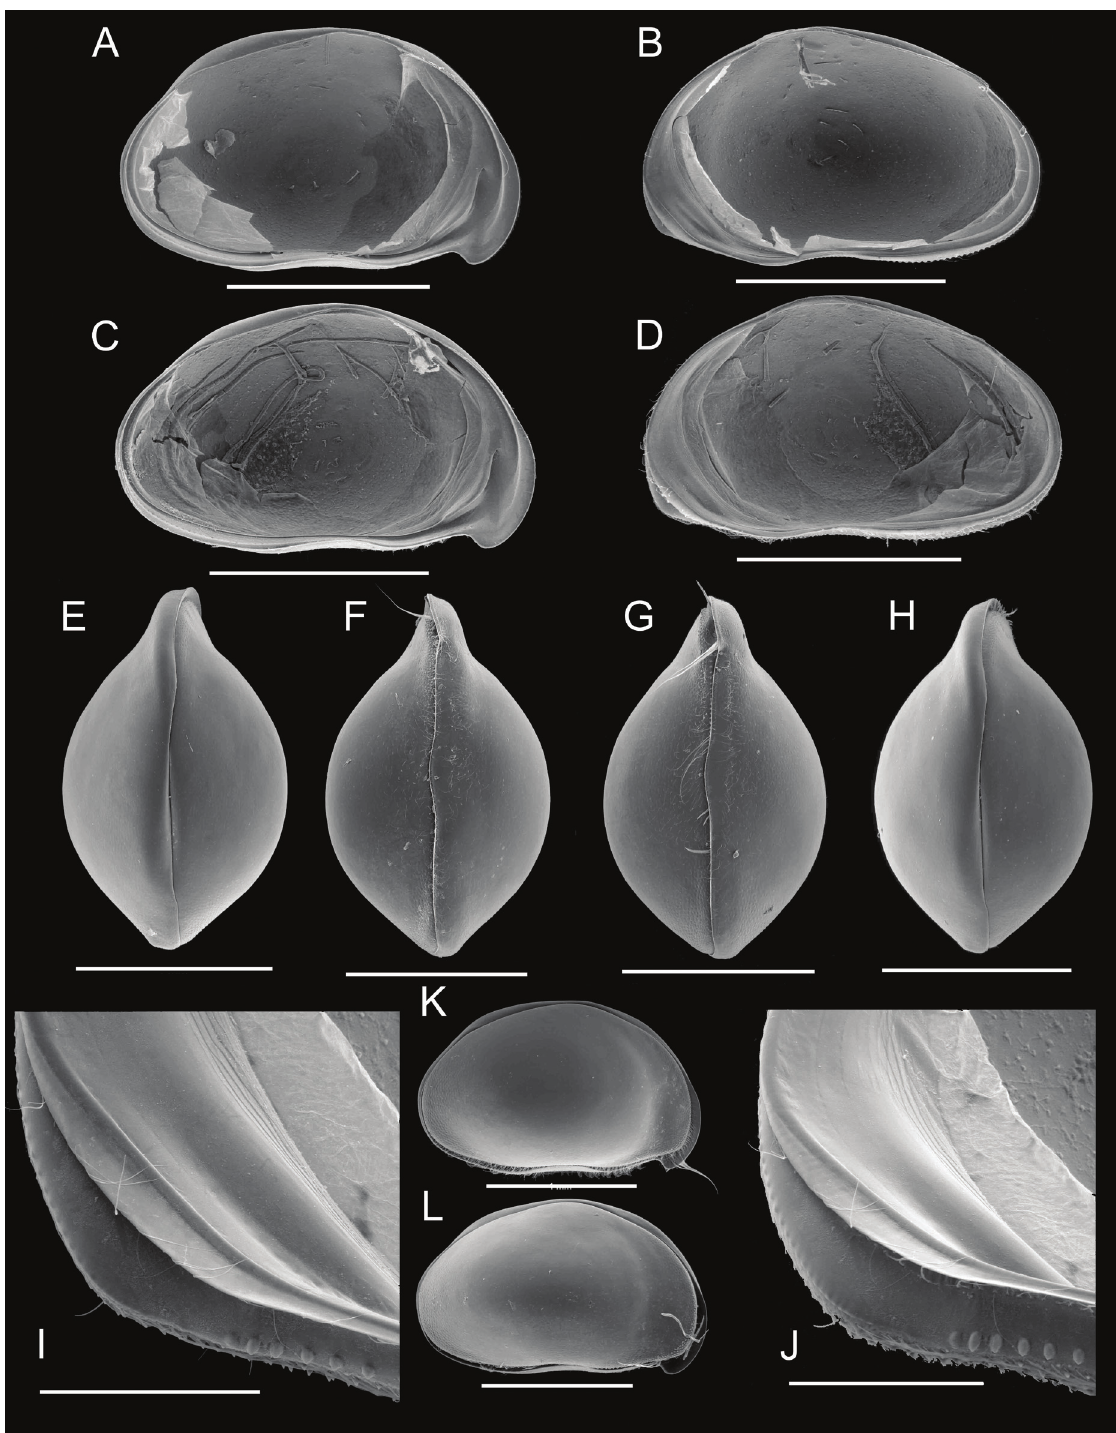
Fig. 21. Bennelongia strelleyensis sp. nov. (all from Strelley station, Pilbara, type locality). A . LVi (allotype ♀, WAM.C49420). B . RVi (♀, Idem). C . LVi (♂, WAM.C49421). D . RVi (♂, Idem). E . Cp dorsal (♀, WAM.C49423A). F . Cp ventral (♀, WAM.C49423B). G . Cp ventral (♂, WAM. C49424B). H . Cp dorsal (♂, WAM.C49424A). I . RVi (detail anteriorly, allotype ♀, WAM.C49420). J . RVi (detail anteriorly, ♀, Idem). K . CpRL (♀, WAM.C49423C). L . CpRL (♂, WAM.C49424A). Scales: A-H, K = 1000 µm; L = 500 µm; I-J = 200